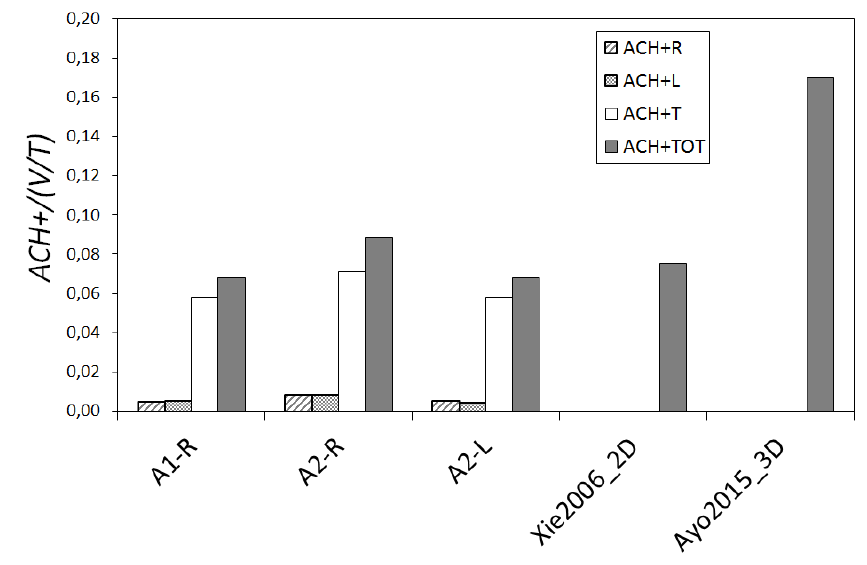
Fig. 2. Total ( ACH+TOT ) and separate ( ACH+R , ACH+L , ACH+T ) air exchange range for the investigated canyons and their individual openings (right R, left L, top T). The study of Xie et al. [11] on 2D street canyon and study of Ayo et al. [12] on 3D stand- alone street canyon is added for comparison.